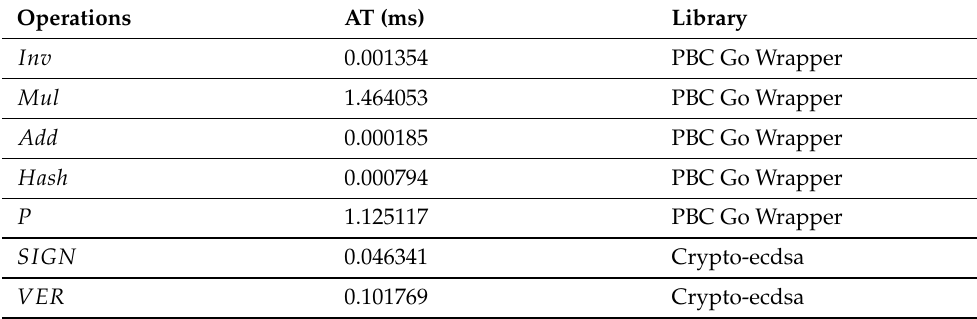
Table 3. Average computation time of each operation. AT = Average